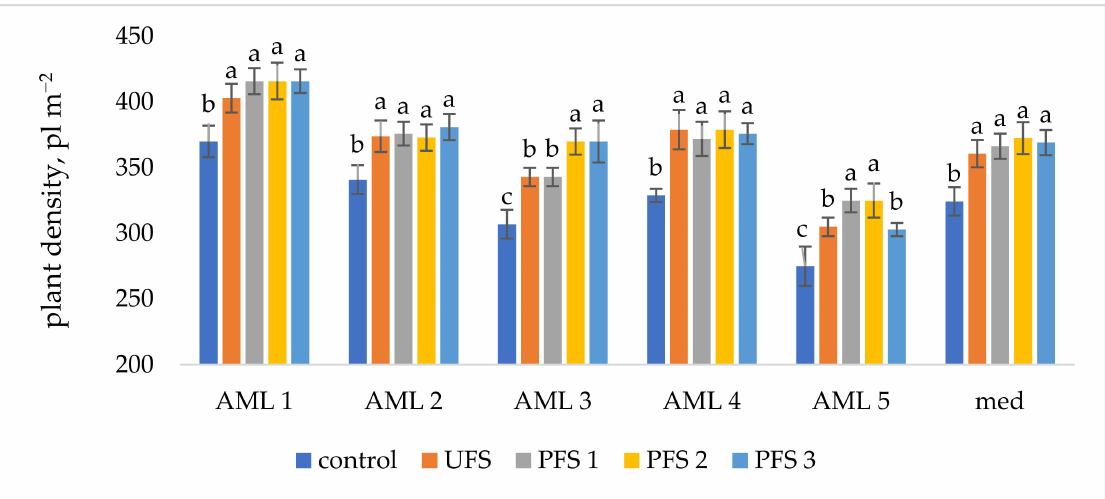
Figure 8. Oat plant density of oat plants in the phase of full ripeness. The different letters represent statistically significant ( p ≤ 0.05) differences between the tested options of fertilizer application. Error bars show the standard deviation of the mean value ( n = 15). AML 1 is the eluvial agricultural microlandscape, AML 2 is the